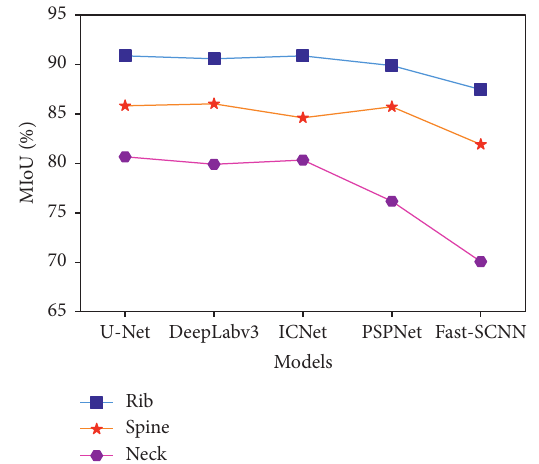
Figure 13: The MIoU of the five segmentation models for the three parts of sheep